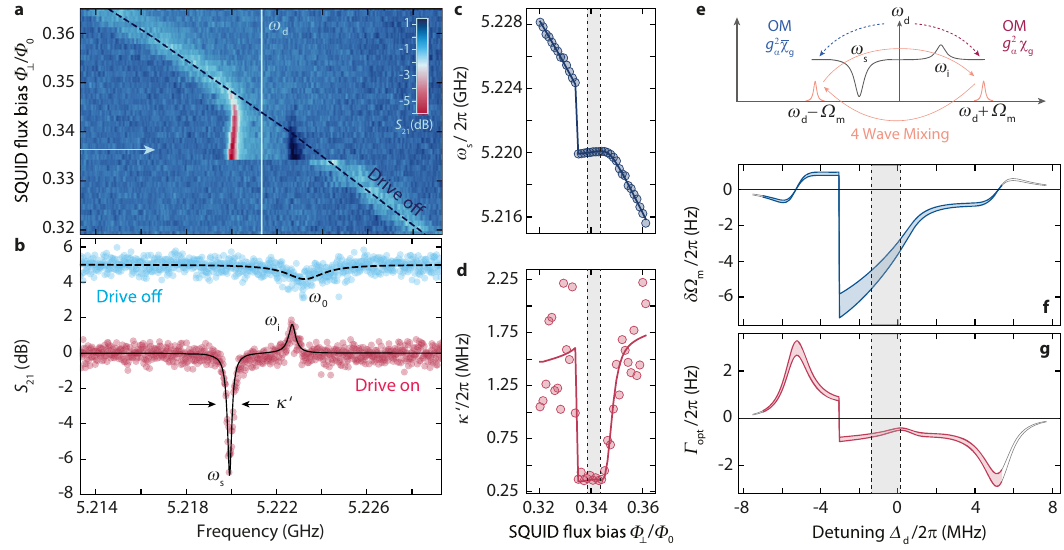
Fig. 2 Cavity stabilization by activation of the Kerr quasi-mode state and single-tone dynamical Kerr backaction. a Color-coded magnitude of the SQUID cavity response S 21 vs SQUID fl ux bias Φ ⊥ / Φ 0 in the presence of a strong drive at ω d . The fl ux-bias range corresponds to a small variation of Φ ⊥ around operation point I and B ∥ = 25 mT. When the fl ux-tunable resonance frequency ω 0 , indicated as dashed line and labeled “ Drive off ” , is far detuned from the drive tone, the cavity response exhibits a single broad absorption resonance. As the detuning between cavity and drive Δ d = ω d − ω 0 is reduced, the cavity response is signi fi cantly modi fi ed and the original resonance is developing into a double-mode structure. The appearance of these driven Kerr quasi-modes indicates the onset of parametric ampli fi cation and degenerate 4WM in the SQUID circuit. We denote the two modes as signal and idler resonance with the resonance frequencies ω s and ω i , respectively. The arrow on the left indicates the position of the linescan shown in panel b . In addition to the linescan from a (red circles) and the result of the analytical response calculation (solid black line), we show the equivalent linescan without parametric drive (blue circles) and its corresponding theoretical response (dashed black line). The curves without parametric drive are offset by + 5 dB for clarity. Panels c and d show ω s and effective linewidth κ 0 of the signal resonance vs fl ux bias. Lines show the result of modeling the effective quantities with the driven Kerr cavity equations and taking into account fl ux-noise broadening and two-level systems. The stabilized regime of operation is indicated by dashed lines and shaded areas. Here, the linewidth is nearly constant with κ 0 = 2 π (cid:2) 340kHz. The width of the operation range corresponds to the fl ux-noise standard deviation, which we estimate to be σ Φ ~ 5 m Φ 0 . Panel e illustrates the dynamical Kerr backaction of the drive fi elds to the nanobeam. Optomechanical (OM) up- and downscattering induces cooling and heating/ampli fi cation to the mechanical mode, respectively, where g α is the multiphoton coupling rate and χ g is the probe- fi eld susceptibility. In addition, interference between up- and downscattered fi elds due to degenerate 4WM has to be taken into account. f and g show the calculated optical spring and optical damping. The two blue/red lines and shaded area correspond to g 0 / 2 π = (1.95 ± 0.1) kHz. The detuning range Δ d is slightly increased compared with a – d . In the additional range, the backaction is plotted in